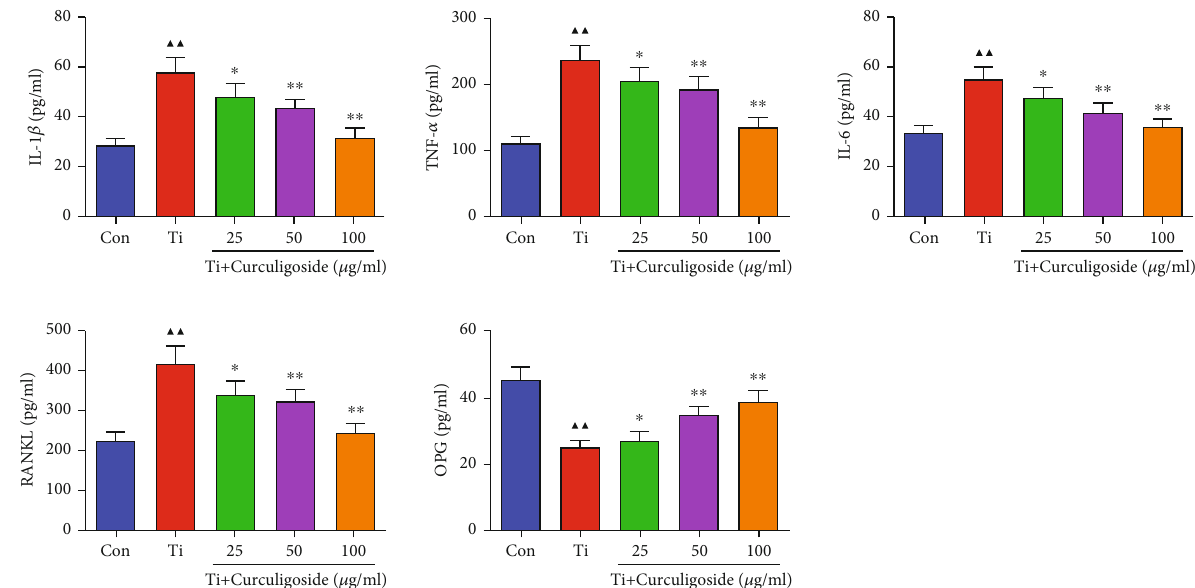
Figure 3: The levels of TNF- α , IL-1 β , IL-6, RANKL, and OPG in MC3T3-E1 cells were detected using ELISA kits ( n = 3 ); results are represented as the mean ± SD . ▲ P < 0 : 05 , compared to the Con group; ▲▲ P < 0 : 01 , compared to the Con group; ∗ P < 0 : 05 , compared to the Ti group; ∗∗ P < 0 : 01 , compared to the Ti group. Ti: titanium particle; Con: